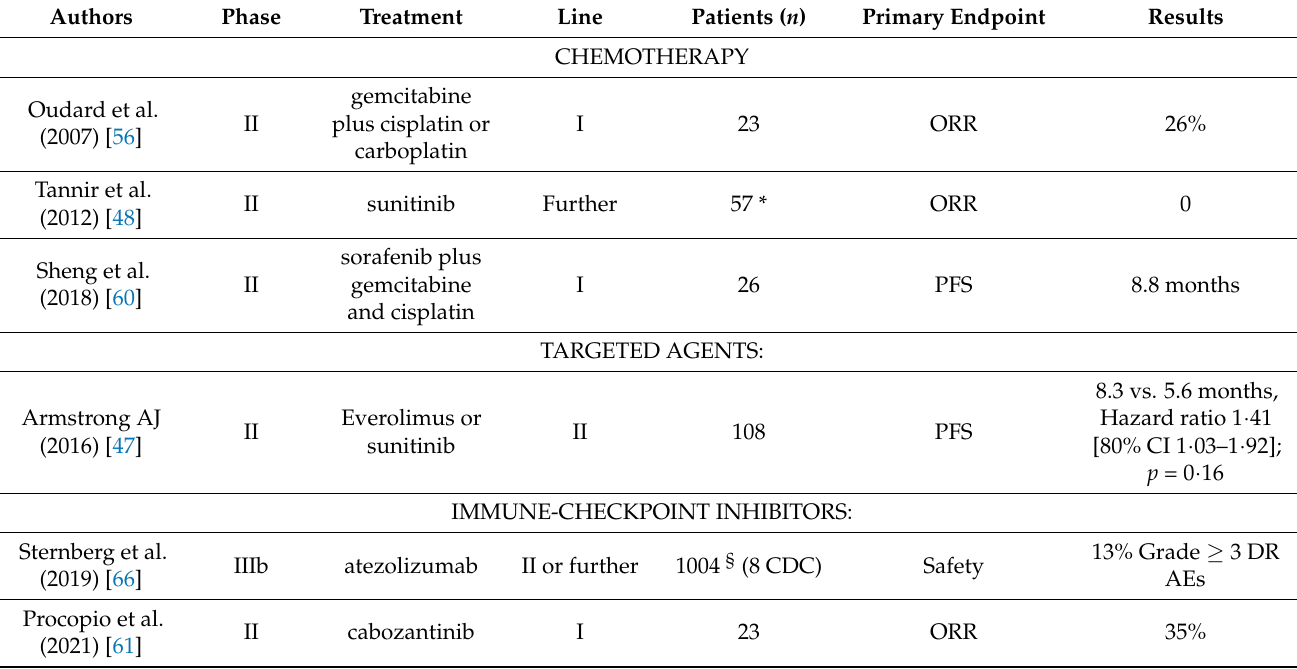
Table 4. Completed clinical trials evaluating treatment regimens for mCDC patients. ORR: objective response rate; PFS: progression free survival; DR: drug-related; AEs: adverse